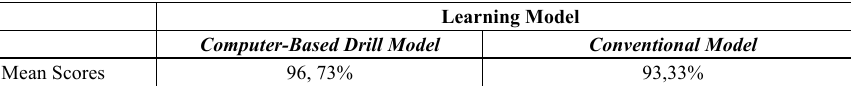
Table 3. The Mean of Learning Implementation